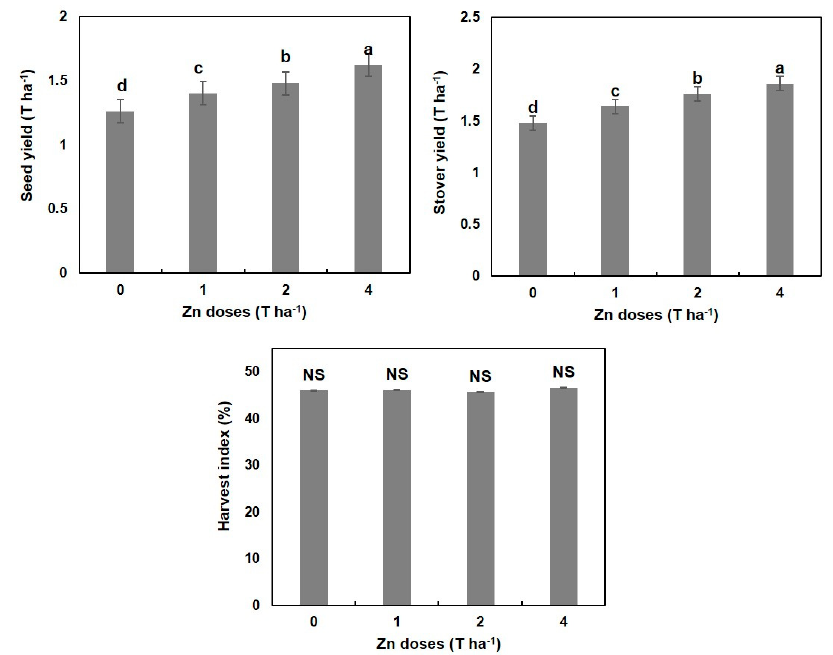
Figure 2. Zn’s impact on Seed and Stover Yield, Harvest Index of Mustard. Figures with same letter (s) or without letter do not differ significantly, whereas figures with dissimilar letters differ significantly as per DMRT. NS = Not significant.